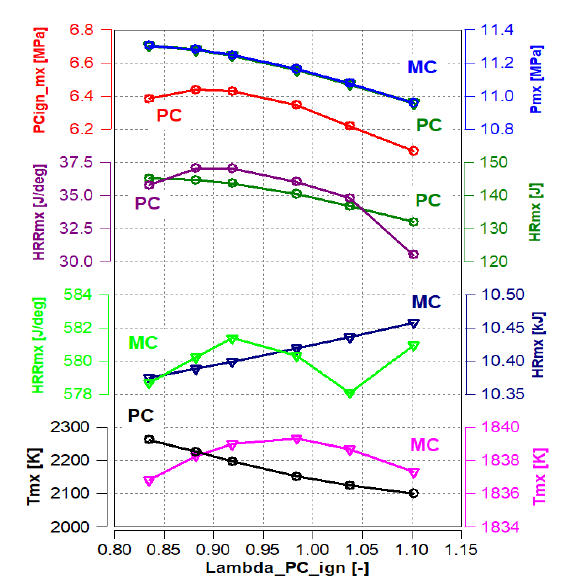
Fig. 19. Changes in combustion process indicators at different air excess ratio at PC_ign